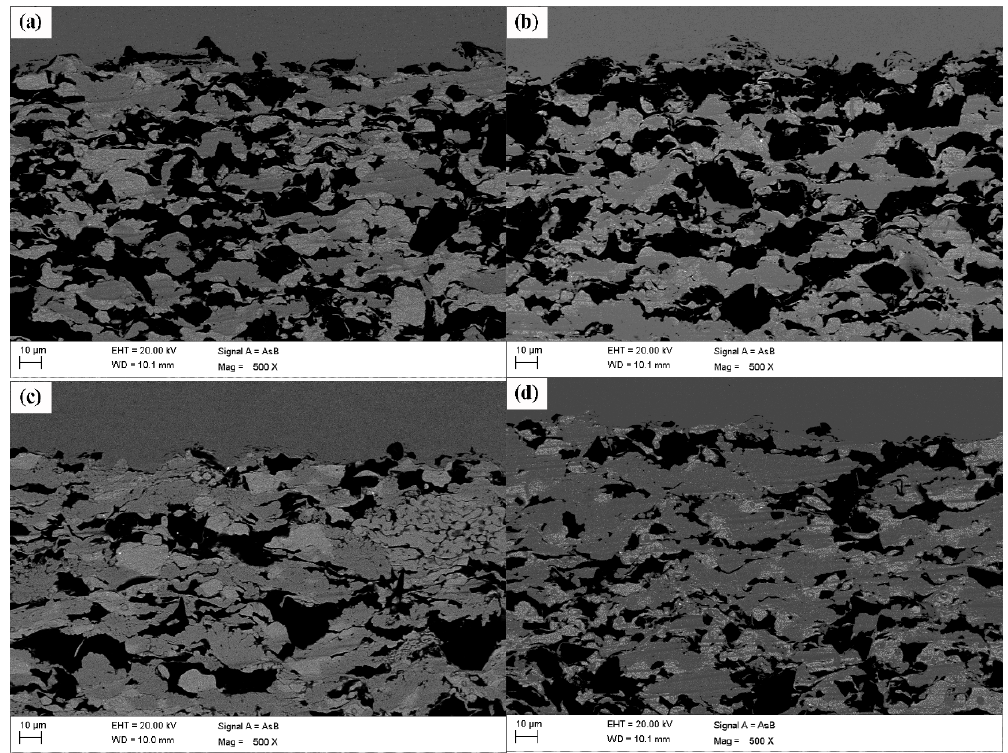
Figure 4. SEM image of the cross section of the composite coatings with different Ni powder contents: ( a ) 10 wt %, ( b ) 15 wt %, ( c ) 20 wt % and ( d ) 25 wt %. The darkest areas are the irregular alumina ceramic, the dark-gray areas are Ni, and light-gray areas are Zn.